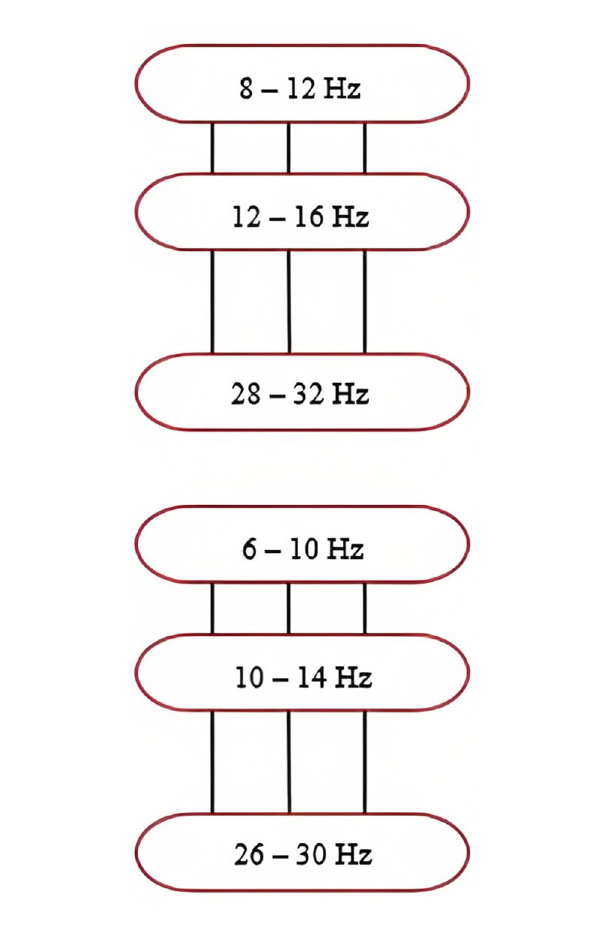
FIGURE7 Frequency ranges of filters within the filter bank. Note that the overlapping frequencies minimize information loss. Taken from Khan et al.